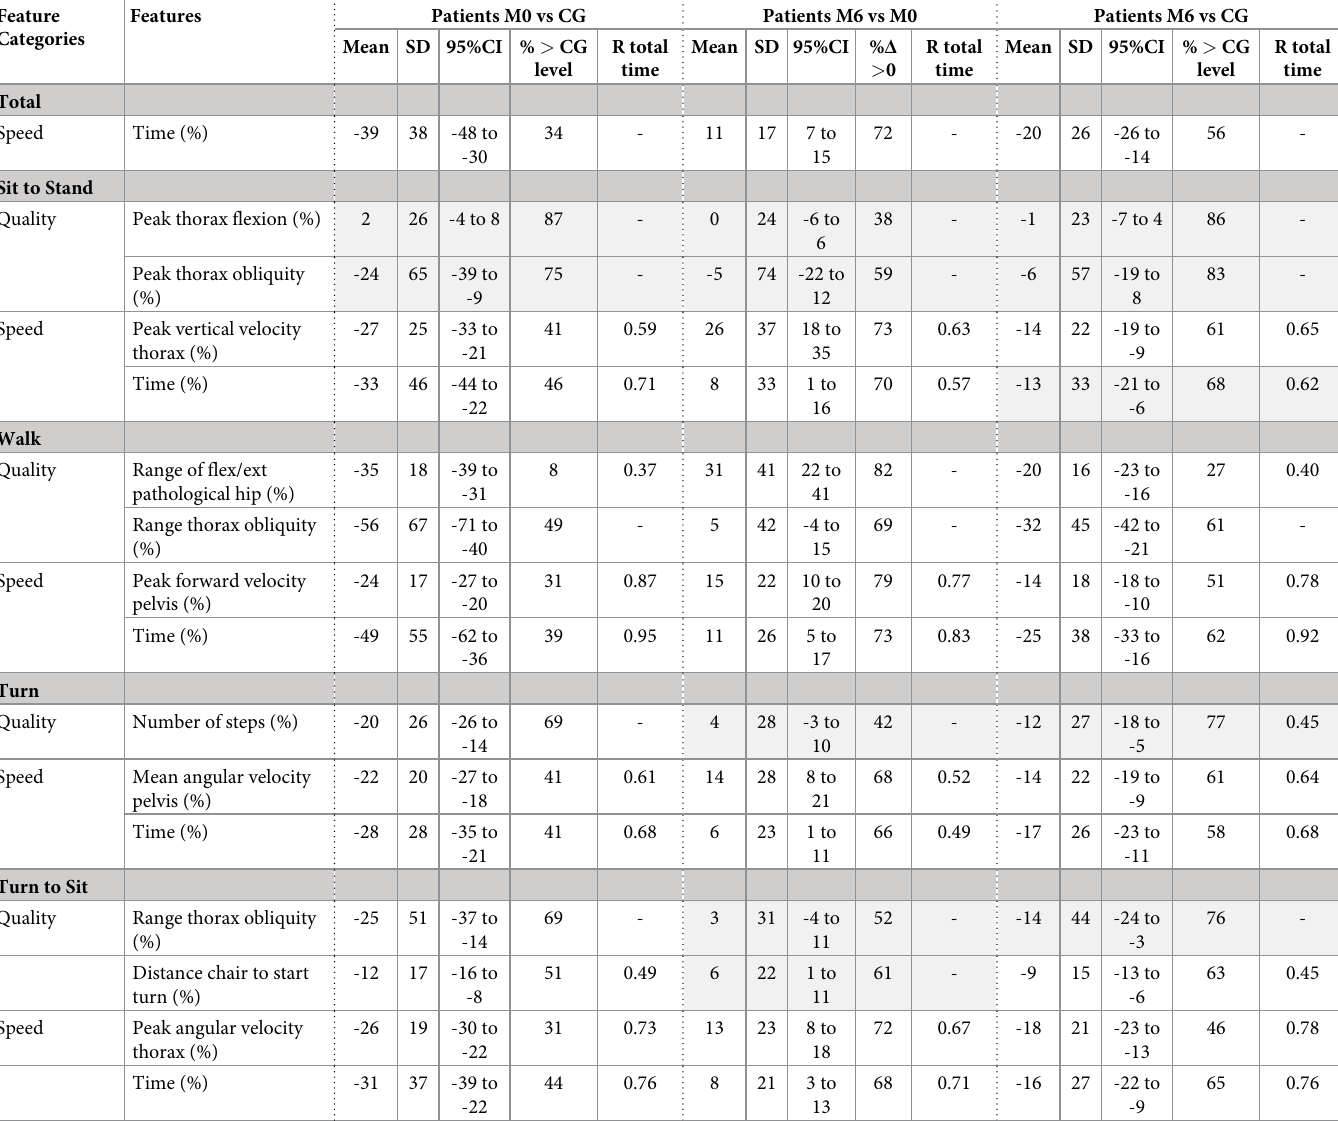
Table 6. Mean, SD and 95% confidence interval of the significant differences between groups, i.e. differences between patient and control groups and between patients before and six months after